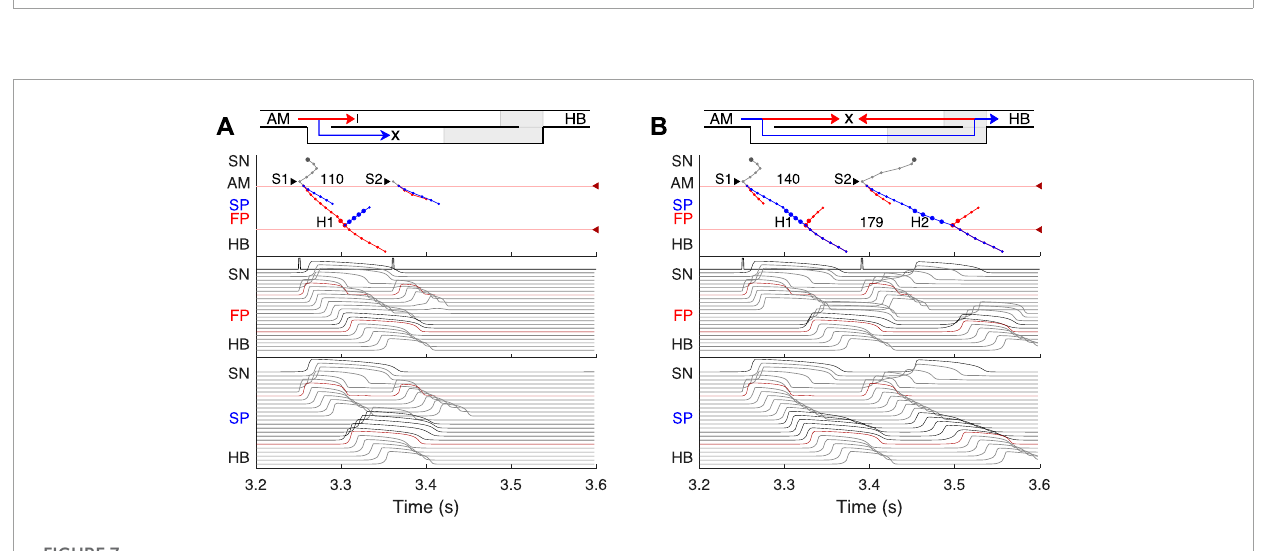
conduction curve calculation during atrial pacing are presented